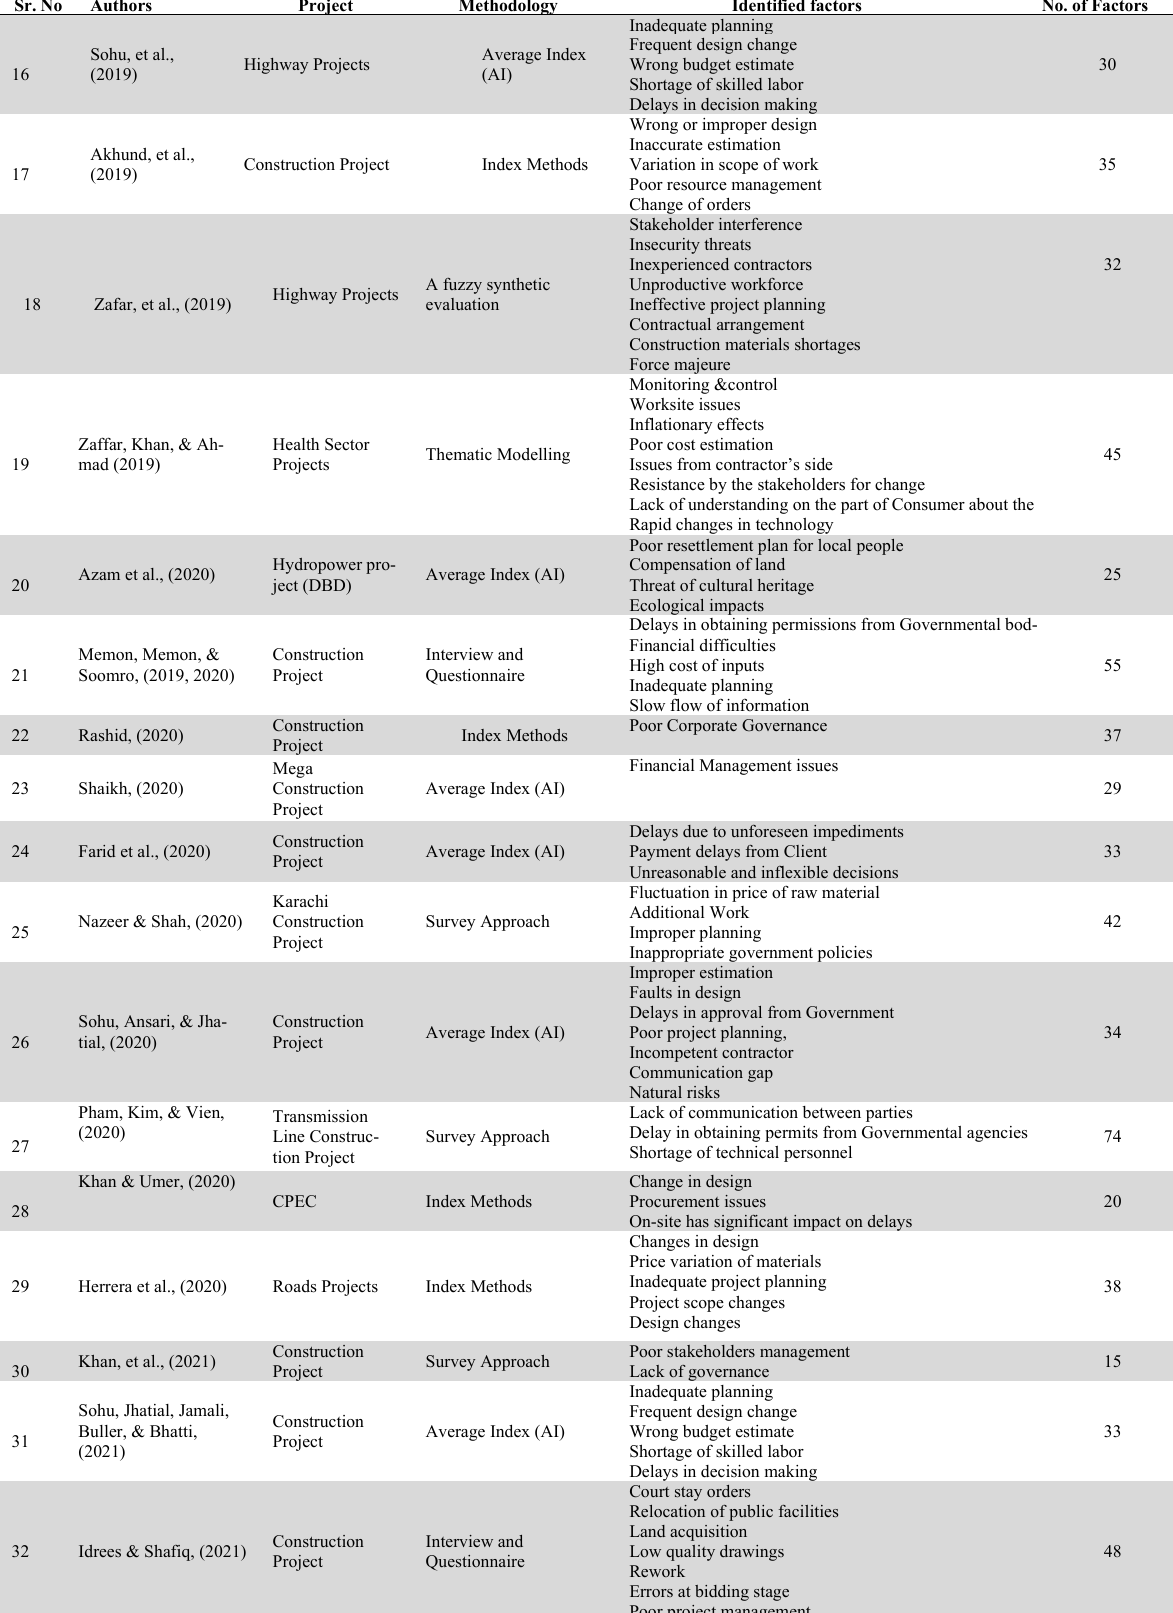
Existing Literature of Identified Factors Related to Cost and Time Delays in Construction Projects (Continued) Sr.